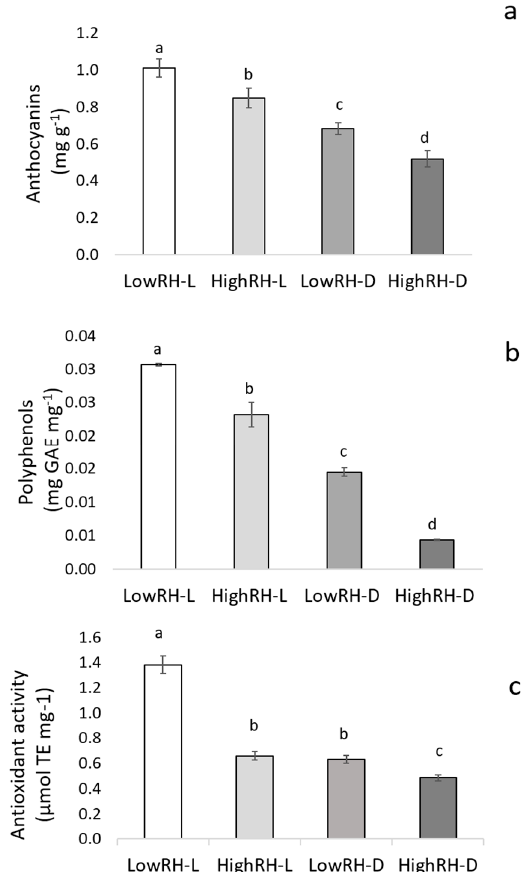
Figure 2. Concentration of anthocyanins ( a ), polyphenols ( b ) and antioxidant activity ( c ) in mung bean sprouts grown under the four di ff erent combinations of RH and LR (LowRH-L; LowRH-D; HighRH-L; HighRH-D). Mean values and standard errors are reported; di ff erent letters refer to statistically significant di ff erences; p ≤ 0.05).